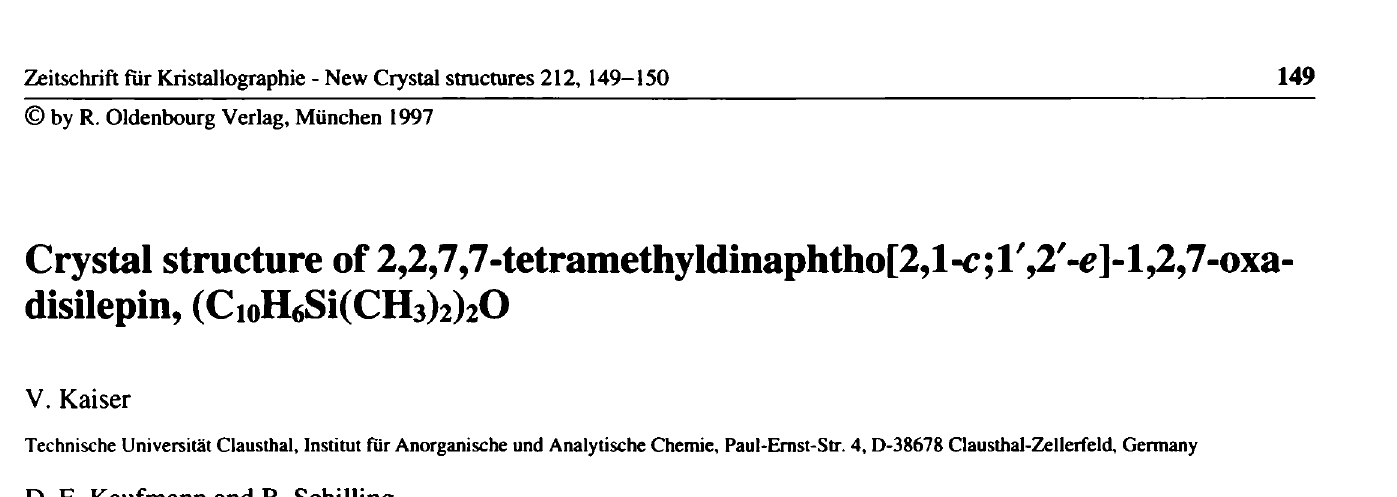
Table 1. Parameters used for the X-ray data collection